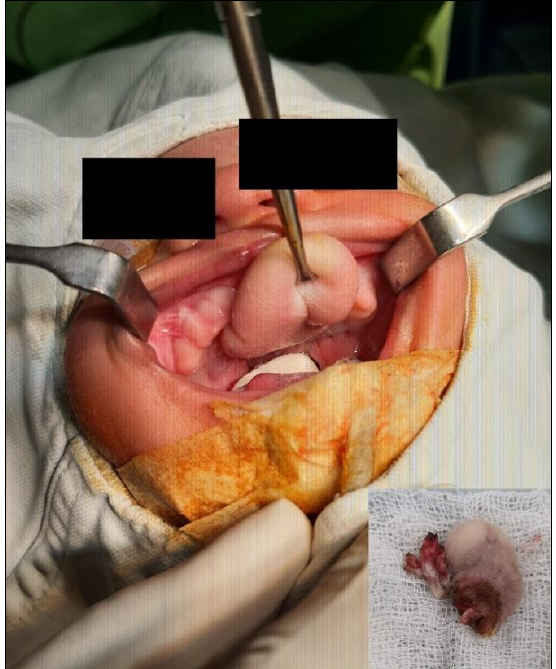
Figure 1: Tongue-shaped growth arising from the palate. Inset showing excised tissue. Intubation was possible after pulling the mass upward. Complete excision of the mass was possible transorally using monopolar diathermy. After excision, the palate's mucosal wound was left open for secondary healing. The postoperative period was uneventful. The repair of the palate shall be planned after nine months of